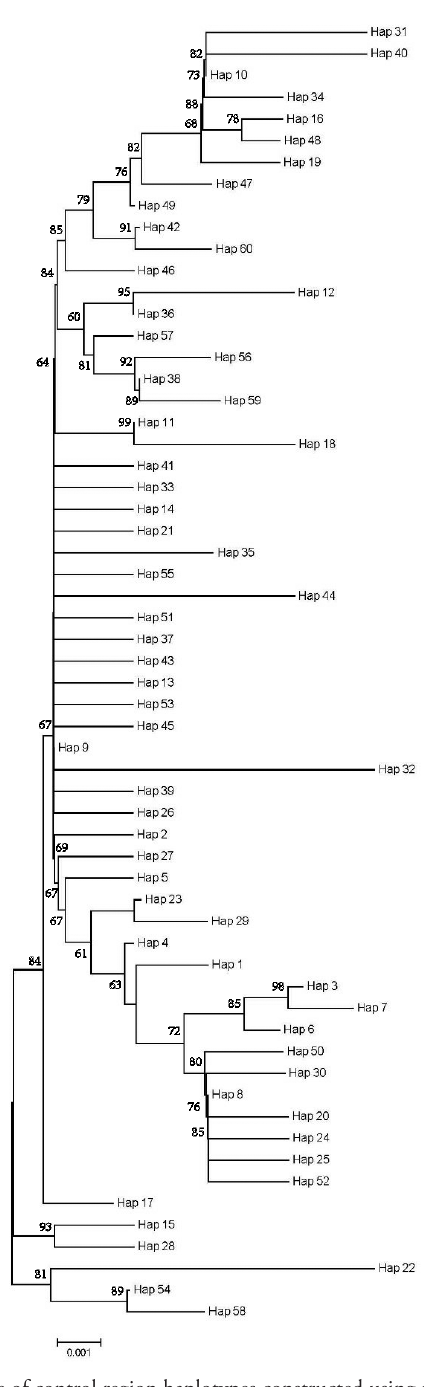
Figure 2. Phylogenetic tree of control region haplotypes constructed using neighbor-joining algorithms of J. grypotus